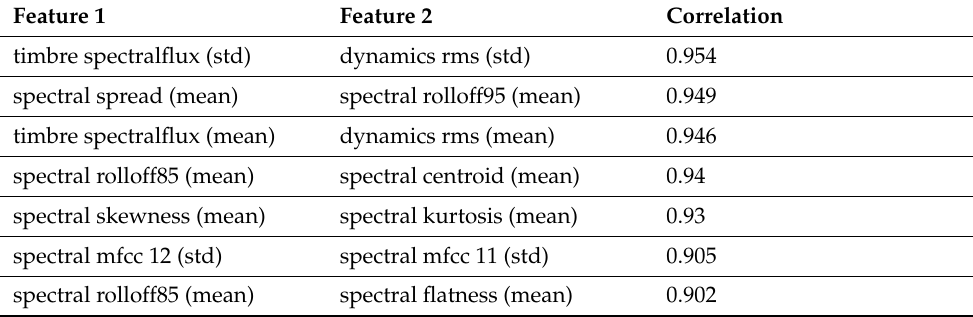
Table 4. Highly correlated features in the EmoSoundscape dataset.